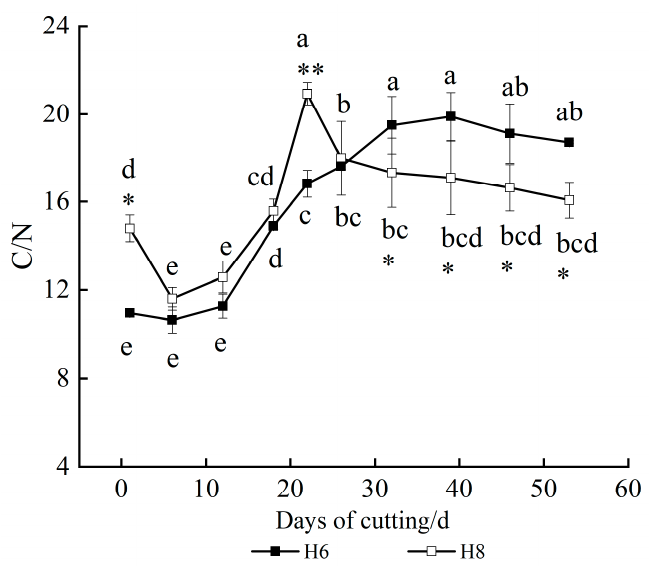
Figure 9. Changes in C/N value in cutting rooting of H6 and H8 in E. ulmoides. The data are shown as the means ± SEs ( n = 3). Means with the same letter are not significantly different in the same group. * indicate significant difference between the H6 group and the H8 group at the same time. * and ** indicate means at the level of 0.05 and 0.01, respectively.